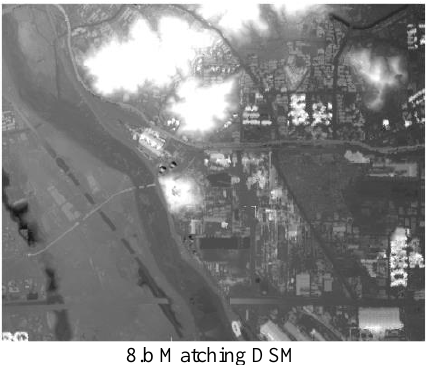
Figure 8. Comparison of laser DSM and matching DSM The different was computed by the minus of the interpolated heights from laser DSM and matching DSM. Finally, there were total 2,186 ground check points and 15,768 building check points involved in height difference statistics, excluding change area 、 shadow area and lack of texture area. The elevation accuracy of our generated DSM for bare ground area is 0.45m, while for buildings is